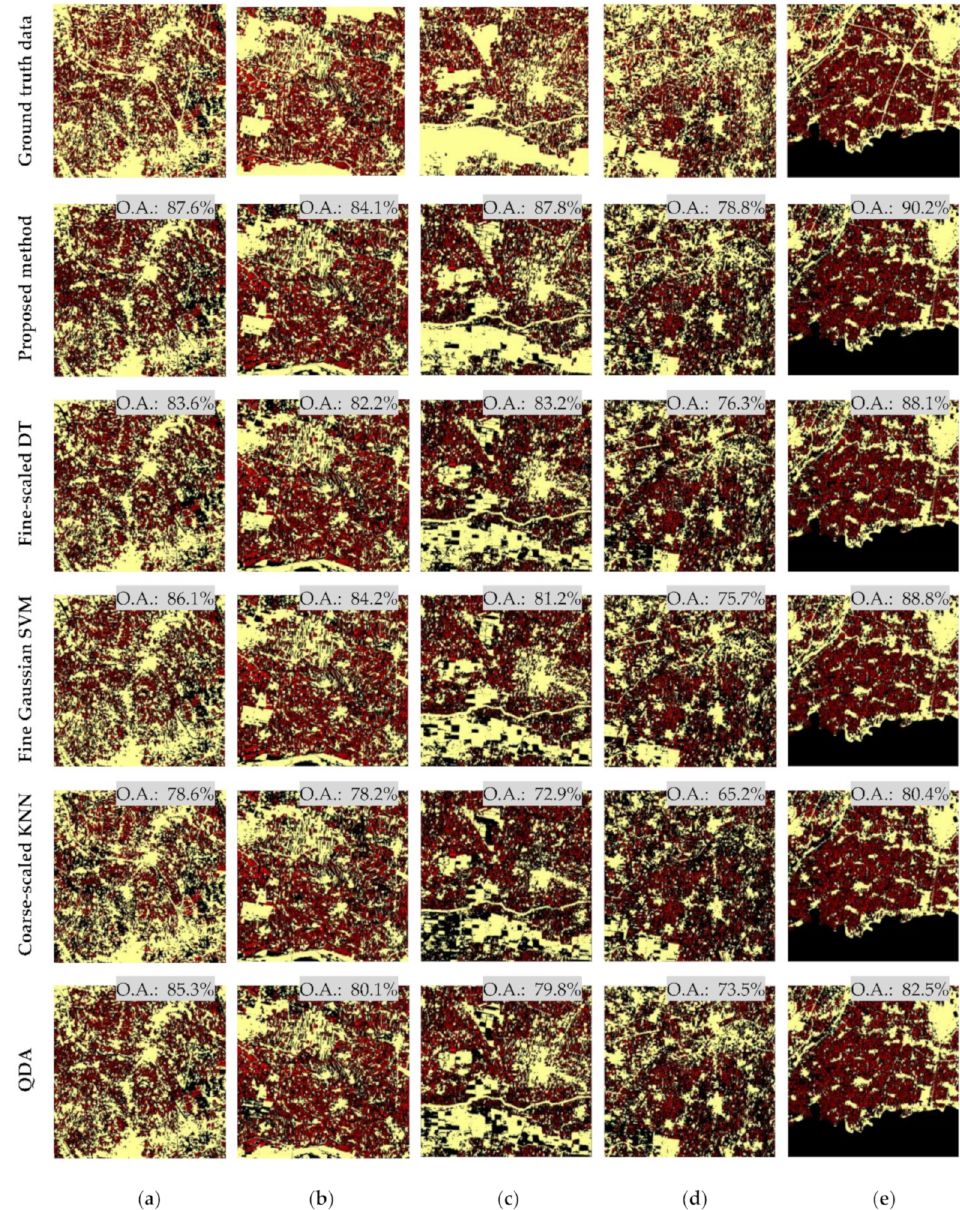
Figure 10. The rice-field detection of the five selected regions. ( a – e ) corresponding to regions 1–5 in Figure 8, respectively. The top row shows the ground truth data (corresponding to Figure 9), the remaining rows show the results from the five classifiers. Rice pixels are shown in red, non-rice pixels in yellow and non-interesting pixels in